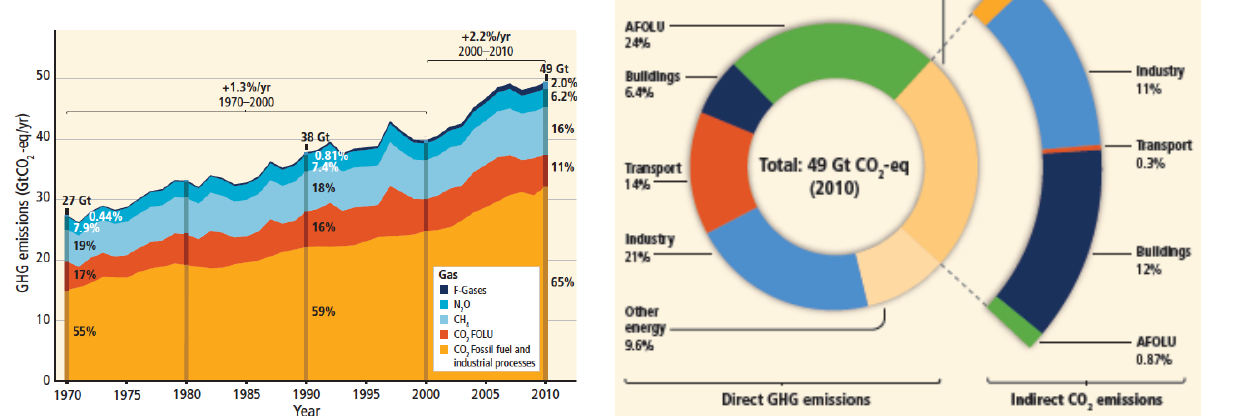
Figure 4. Total annual anthropogenic GHG emissions in gigatonnes of CO 2 -equivalent per year (GtCO 2 -eq/yr) for the period 1970 to 2010 by gases: CO 2 from fossil fuel combustion and industrial pro- cesses; CO 2 from Forestry and Other Land Use (FOLU); CH 4 ; N 2 O; gases covered under the Kyoto Protocol (F-gases) (from IPCC, 2014).